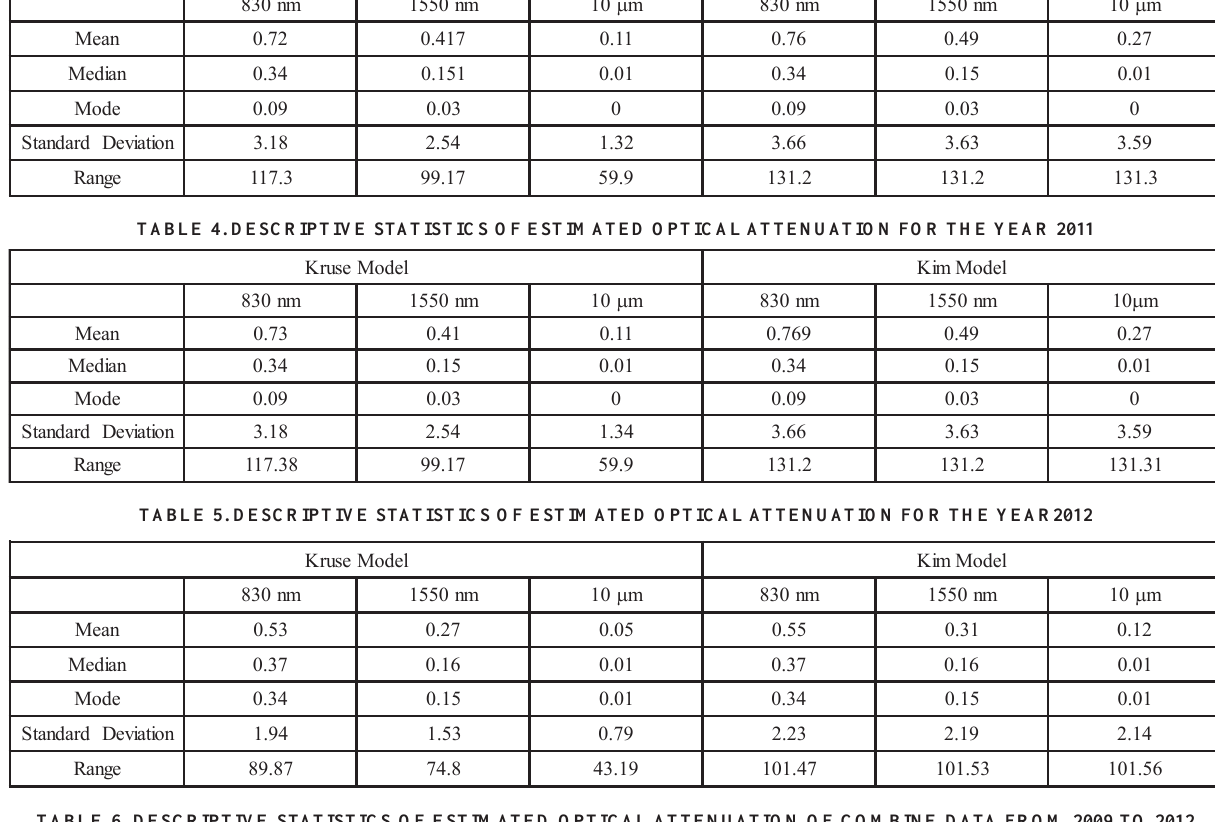
TABLE 6. DESCRIPTIVE STATISTICS OF ESTIMATED OPTICAL ATTENUATION OF COMBINE DATA FROM 2009 TO 2012